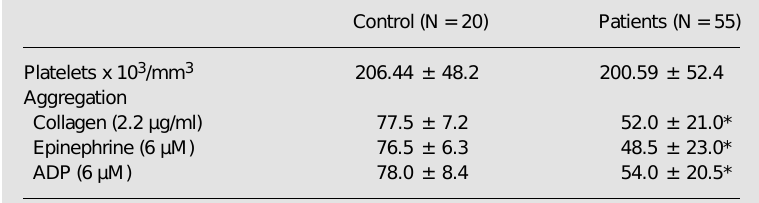
Table 1. Platelet concentration and